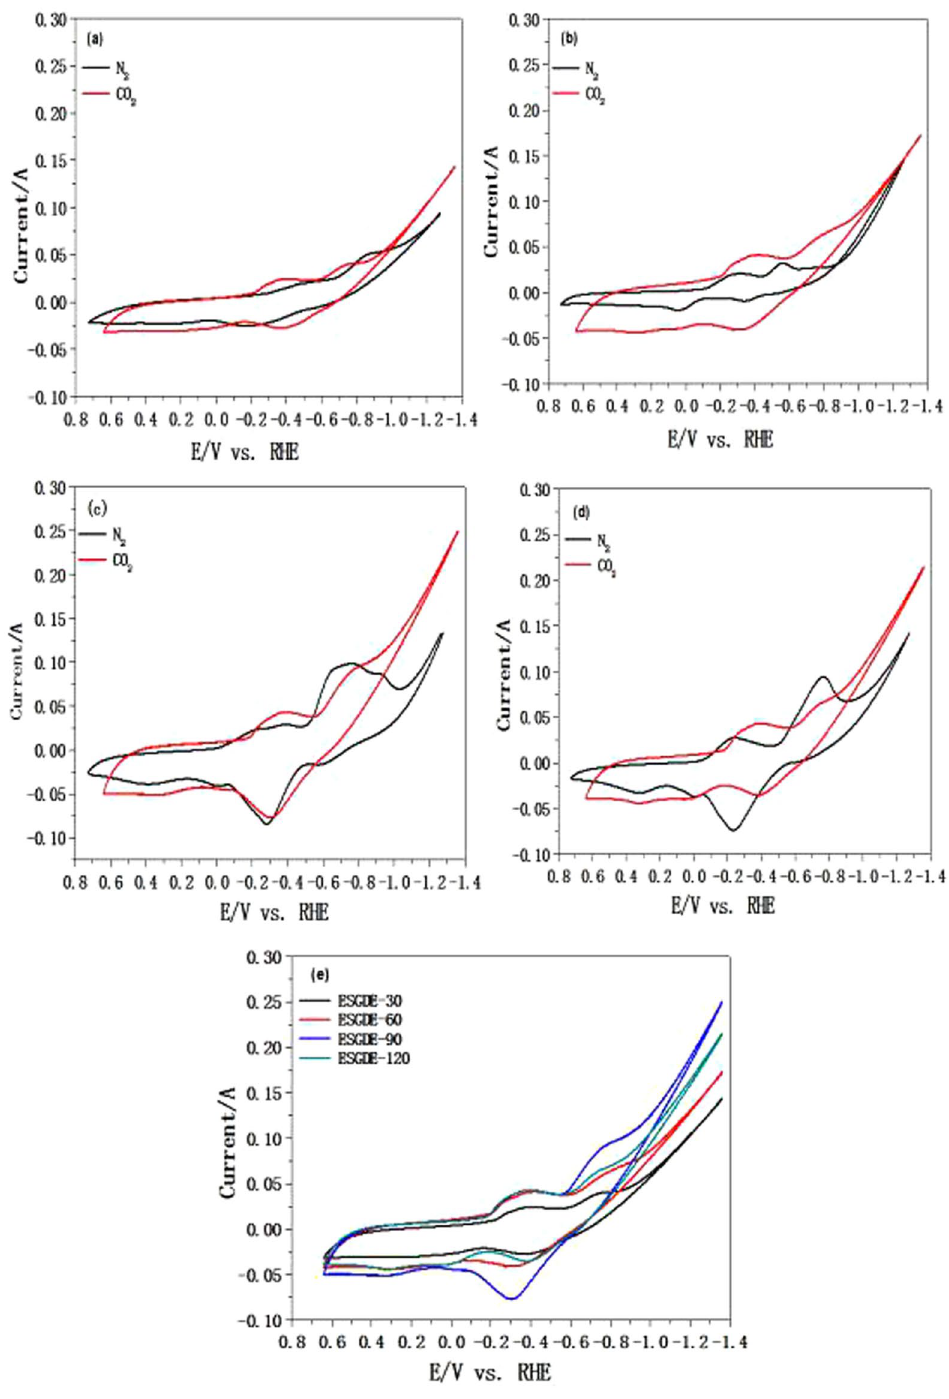
Figure 5. CVs obtained from the ESGDEs with electrodeposition time of 30 s ( a ), 60 s ( b ), 90 s ( c ) and 120 s ( d ) in 0.5 M N 2 -saturated KHCO 3 solution (pH = 8.92) and CO 2 -saturated KHCO 3 solution (pH = 7.47), scanning rate: 0.1 V s − 1 . ( e ) Comparison of the CVs obtained from the ESGDEs with different electrodeposition time in 0.5 M CO 2 -saturated KHCO 3 solution (pH =